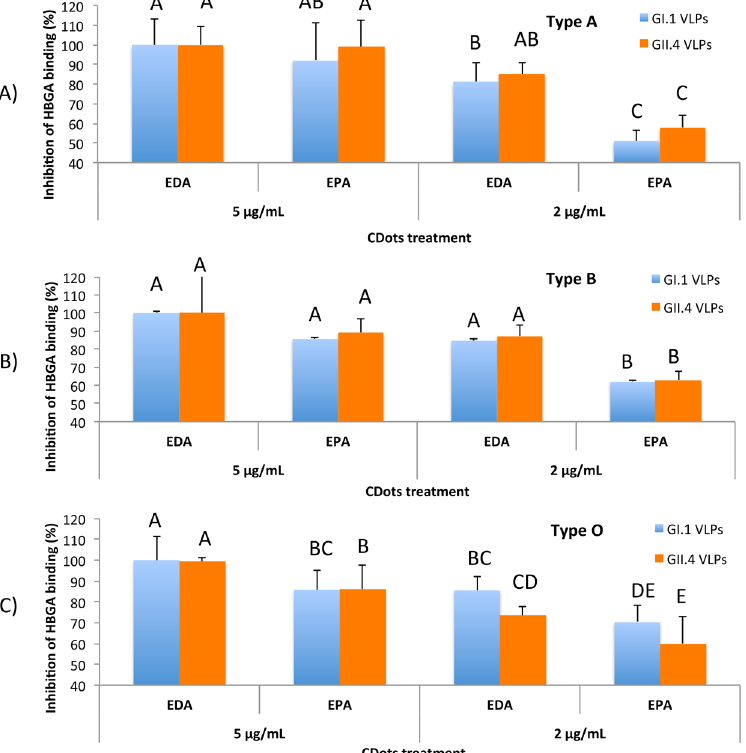
Figure 2. The inhibitory effects of CDots on NoV VLPs’ binding to type A, B, O, saliva HBGA receptors. ( A ) Type A HBGA; ( B ) Type B HBGA; ( C ) Type O HBGA. Different letters on the columns indicate significant differences at P < 0.05, while any same letters on the columns indicate no significant